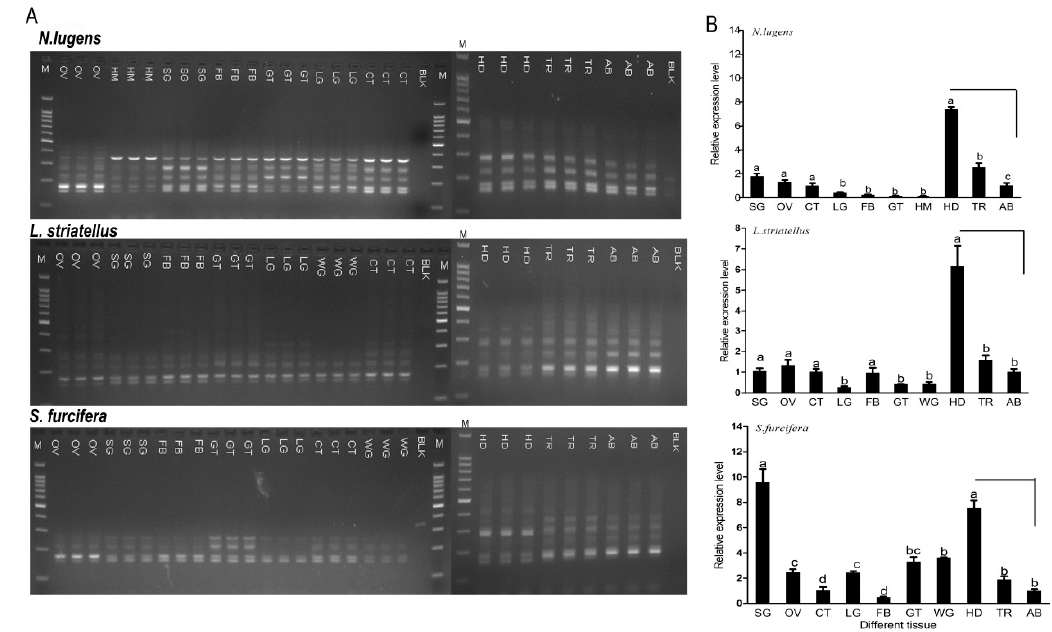
Figure 6. ( A ) RT-PCR products of cDNA templates prepared from total RNA prepared from di ff erent tissues and parts of N. lugens , L. striatellus, and S. furcifera . RT-PCR amplified with primer